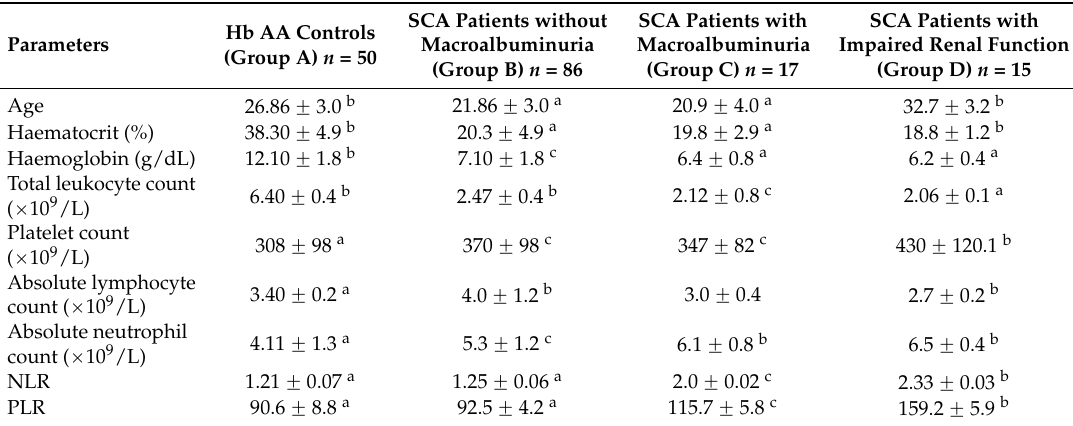
Table 1. Comparison of some haematological indices in sickle cell disease (SCD) patients with macroalbuminuria and chronic kidney disease.